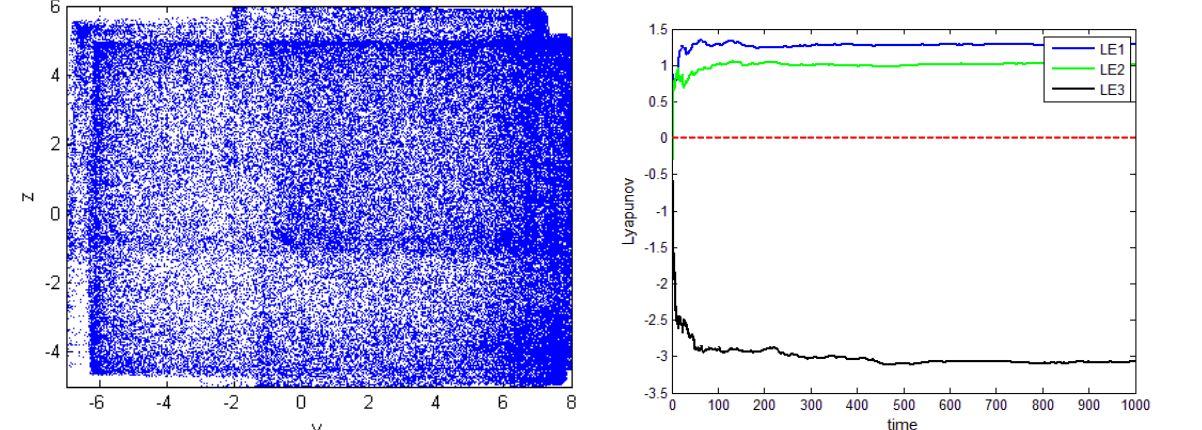
Fig 3. (a) Bifurcation plot, (b) Lyapunov exponent diagram versus parameter time